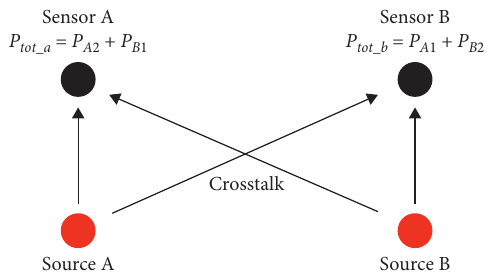
Figure 3: The crosstalk phenomenon represented in the numerical